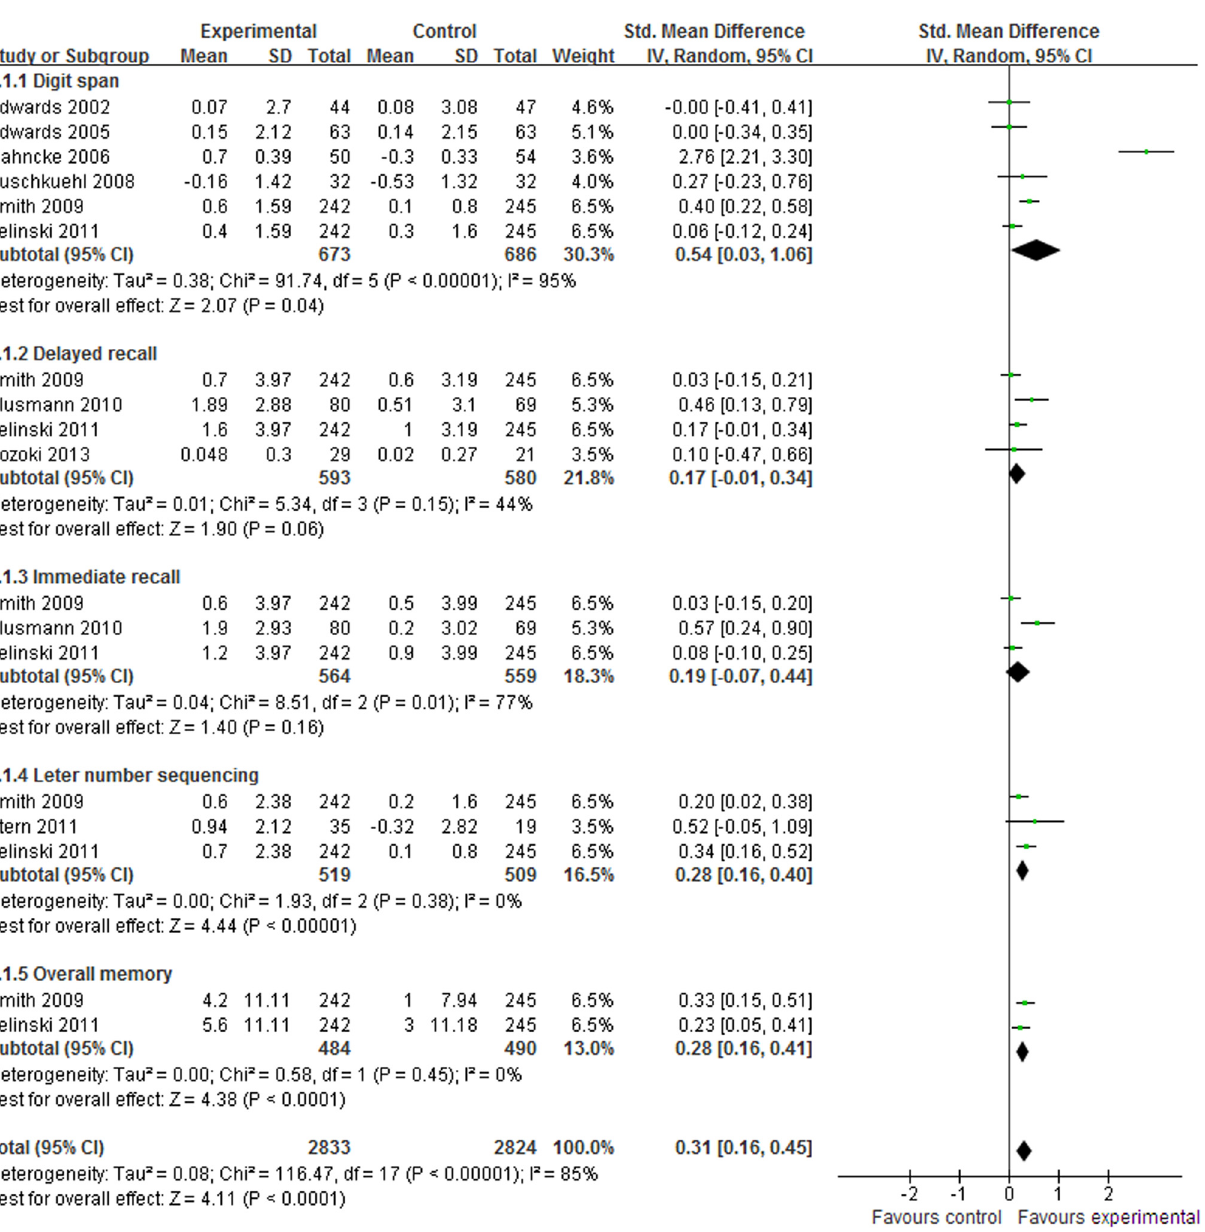
Fig 3. Forest plot of the effect of computer-based cognitive programs in memory